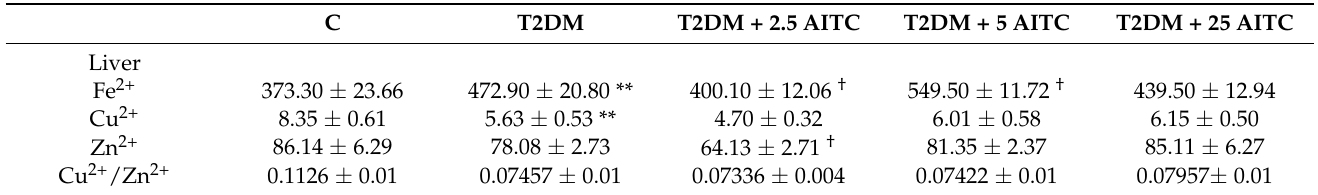
Table 1. The effect of HFD/STZ injection and AITC administration on mineral homeostasis (Fe, Cu, Zn) in the liver, kidney, and spleen of diabetic